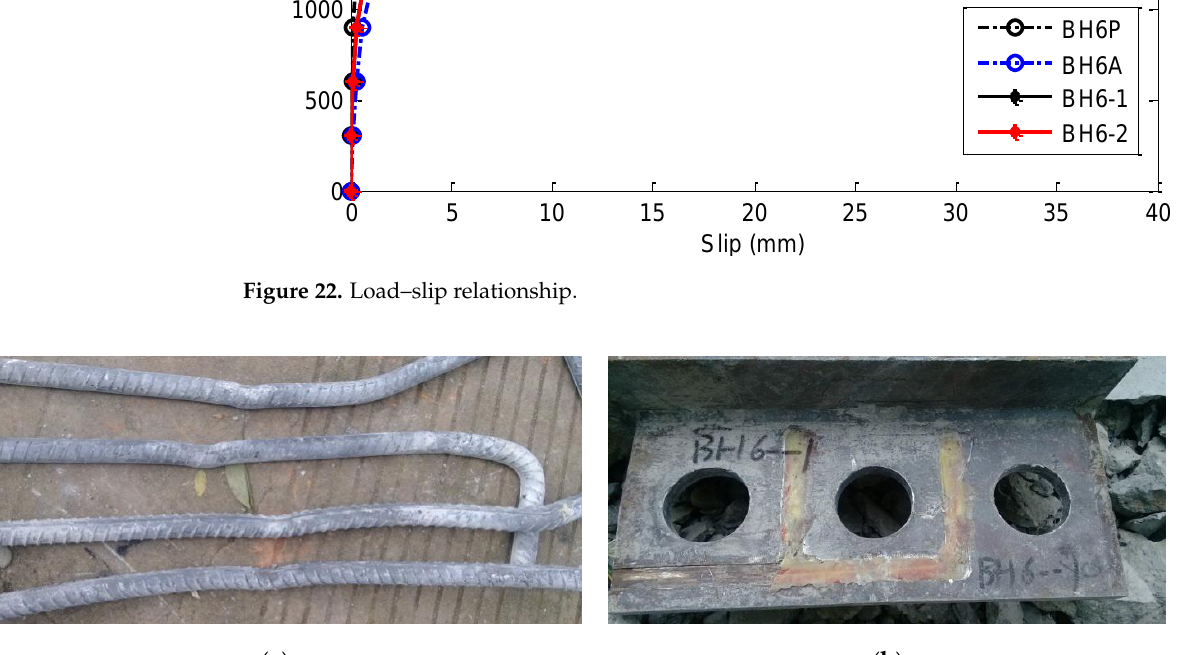
Figure 22. Load – slip relationship.